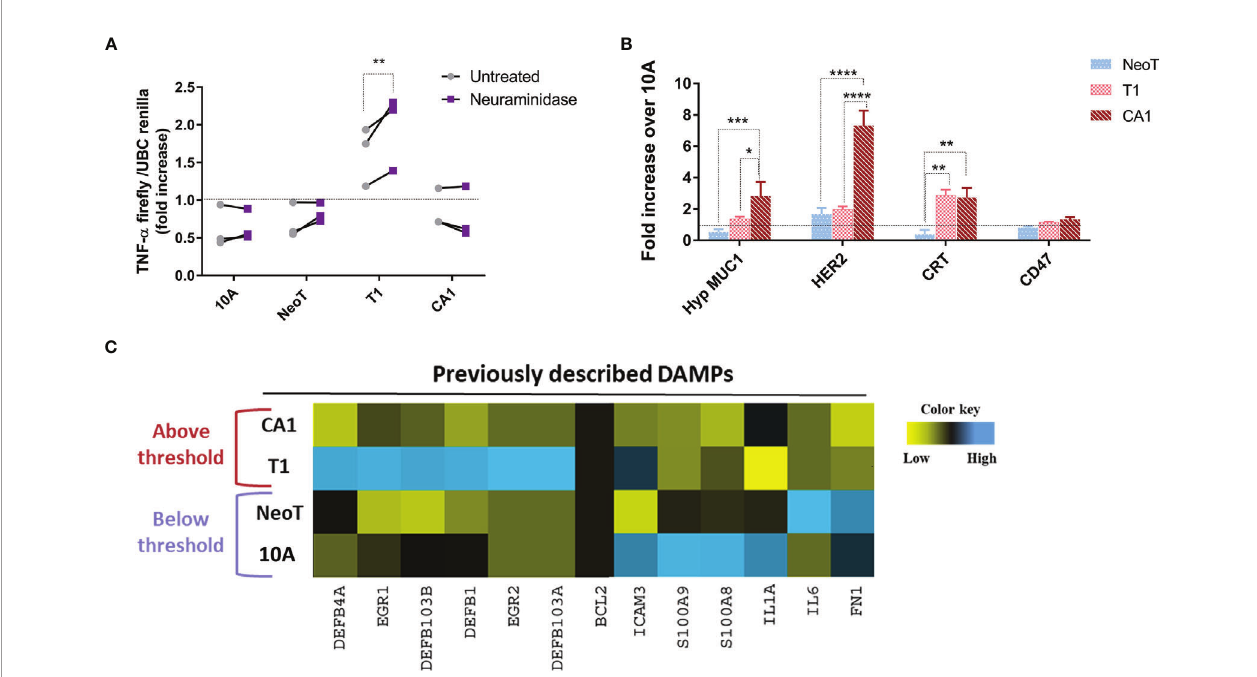
FIGURE 3 | Querying known DAMPs as candidate danger signals for determining macrophage activation threshold in response to transformed cells. (A) Sialic acid removal by neuraminidase treatment of MCF cells, indicated along the X-axis, does not affect the threshold. Y-axis shows fold increase of TNF- a in THP-1 B5 macrophages after 24h incubation at 1:5 macrophage/cell ratio. Co-incubation with untreated cells is in gray and with neuraminidase-treated cells in purple. Results are representative of three experiments. Fisher LSD test: **p<0.01. (B) Differential expression of well-known tumor-associated molecules in indicated cells compared to MCF10A (10A, dashed line), assessed by fl ow cytometry. Results are presented as mean values ± SEM of three experiments. Fisher LSD test: ****p<0.0001, ***p<0.001, **p<0.01, *p<0.05. (C) Heatmap representation of expression of genes coding for previously described DAMPs. The color key was provided by the software and shows a gradient from low (log2 FC < – 1) to high (log2 FC>1)